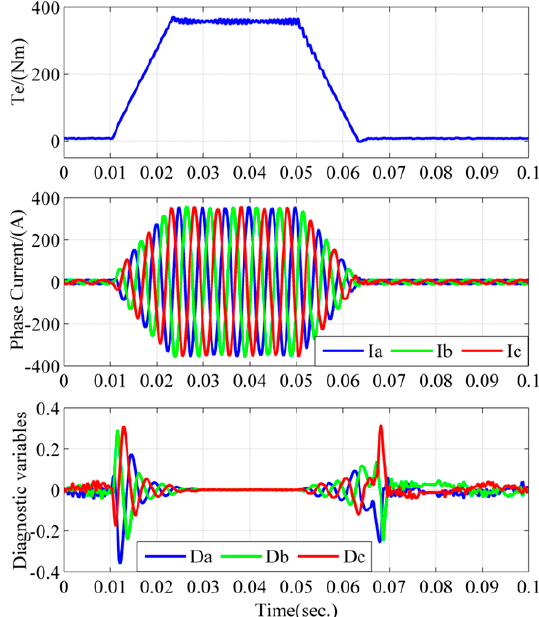
Figure 12. Diagnostic results under a sudden change of load torque conditions.